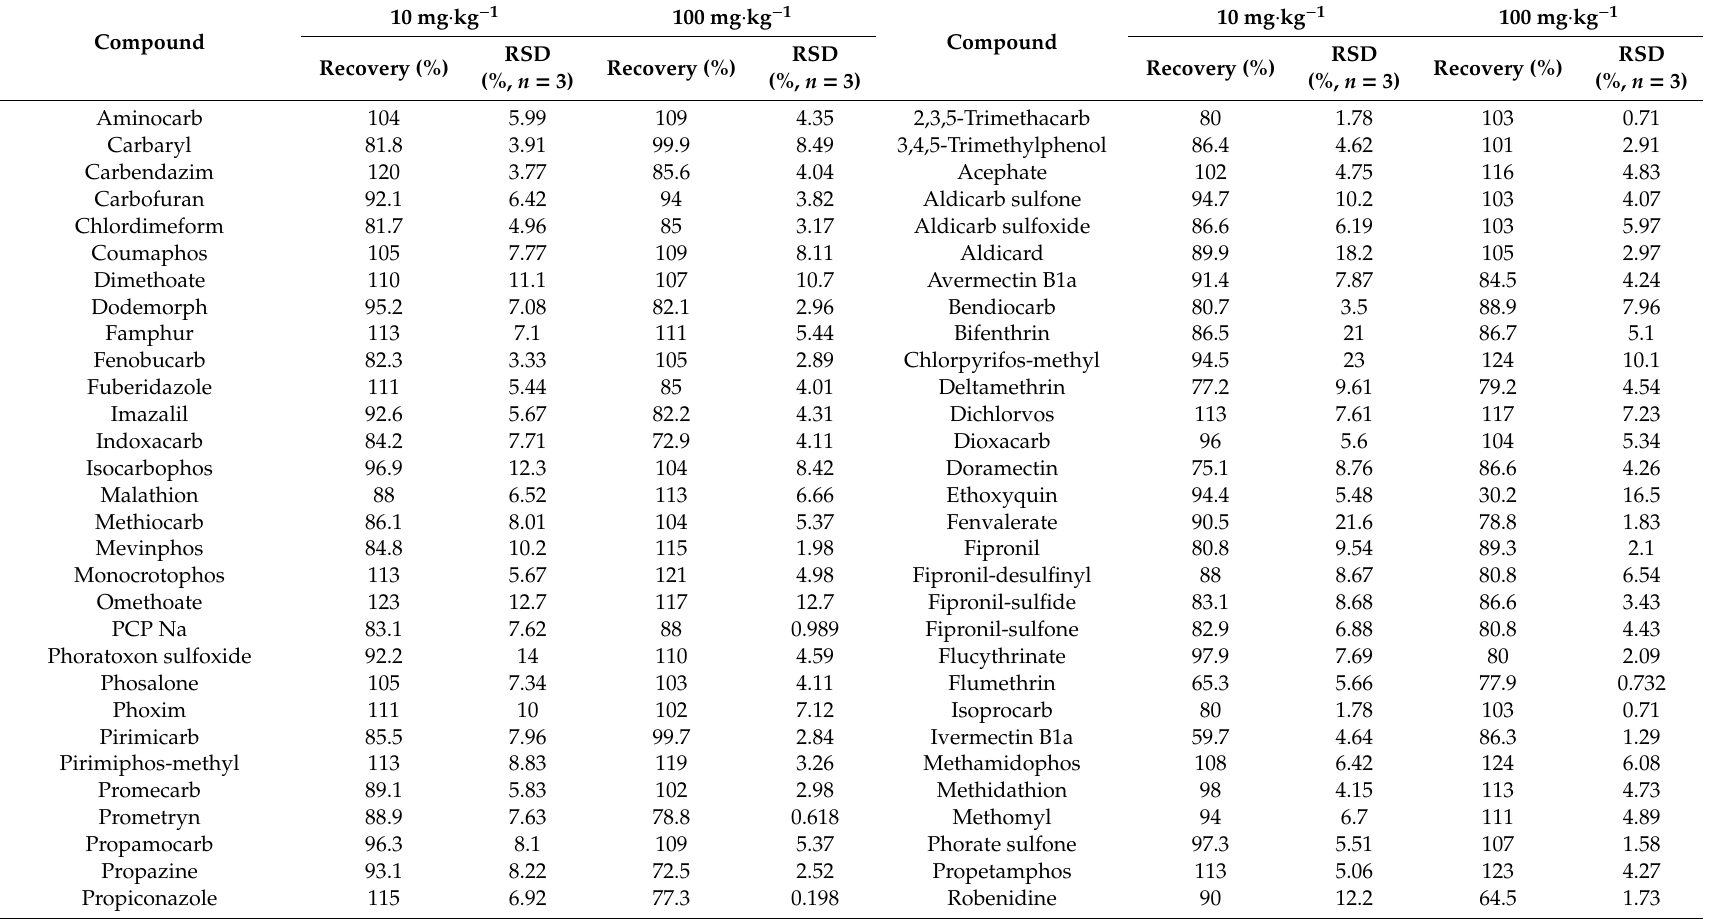
Table 1. Recovery and relative standard deviation (RSD) of each drug at di ff erent spike levels in feedstu ff matrices.